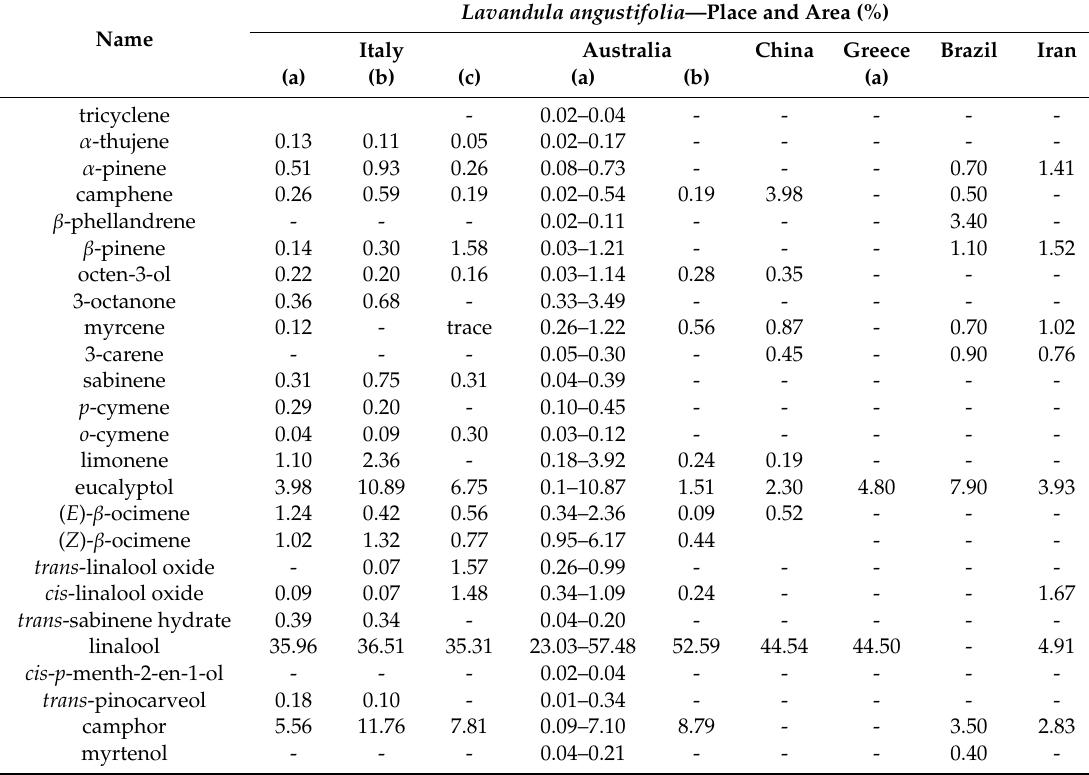
Table 1. The components of lavender oil from Lavandula angustifolia described in the literature.